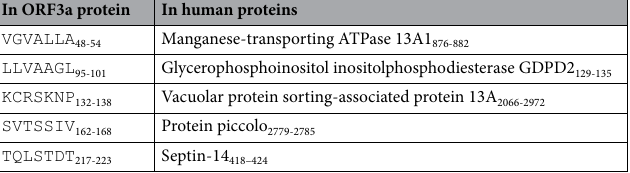
Table 6. Localization of homologous 7-mers in the ORF3a protein and human proteins.